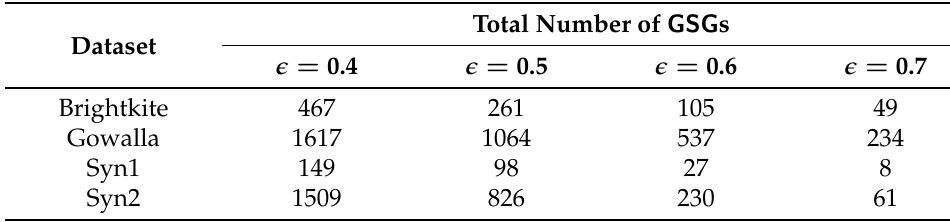
Table 3. Total number of GSG